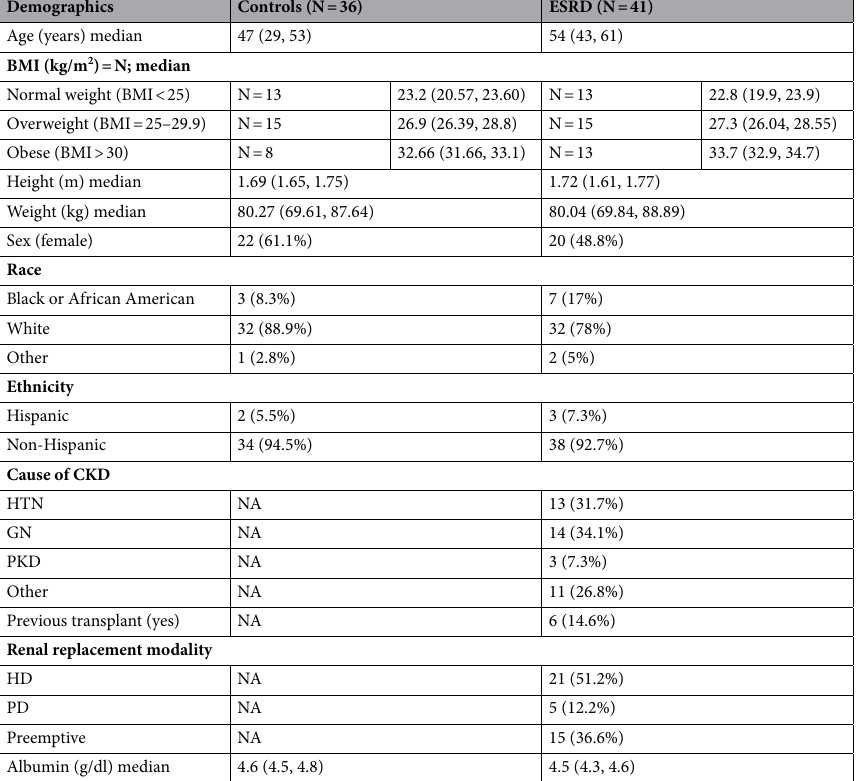
Table 1. Demographic characteristics of the study participants. Age, BMI, height, weight, and albumin are represented as median (Q1, Q3). All categorical data is presented as number (percent). ESRD, end stage renal disease; BMI, body mass index; HTN, hypertension; GN, glomerulonephritis; PKD, polycystic kidney disease; HD, hemodialysis; PD, peritoneal dialysis. Percentage were rounded to nearest decimal